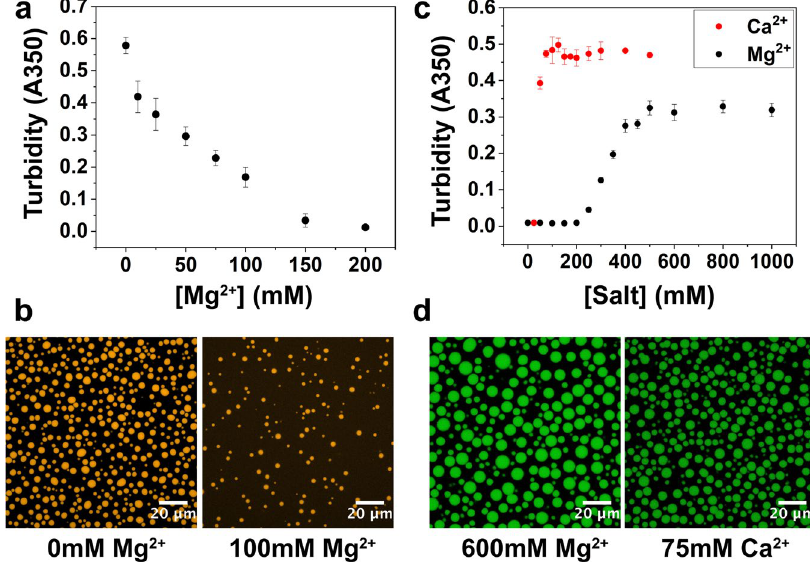
Figure 1. Increase in divalent cation concentration leads to dissolution of heterotypic RP3-polyU droplets and formation of homotypic polyU droplets. ( a ) Solution turbidity measurements of RP3-polyU droplets as a function of [MgCl 2 ]. ([RP3] = 500 µ M, 0.6x polyU wt/wt). ( b ) Confocal fluorescence microscopy images of RP3-polyU droplets under different divalent salt conditions. ([RP3] = 500 µ M, 0.6x polyU wt/wt, 0.5 µ M RP3-AF594). ( c ) Solution turbidity measurements of polyU coacervates as a function of [MgCl 2 ] and [CaCl 2 ]. (1 mg/mL polyU). ( d ) Confocal fluorescence microscopy image of polyU coacervates. (1.5 mg/mL polyU, 600 mM MgCl 2 , 0.5 µ M FAM-UGAAGGAC) (1.5 mg/mL polyU, 75 mM CaCl 2 , 0.5 µ M